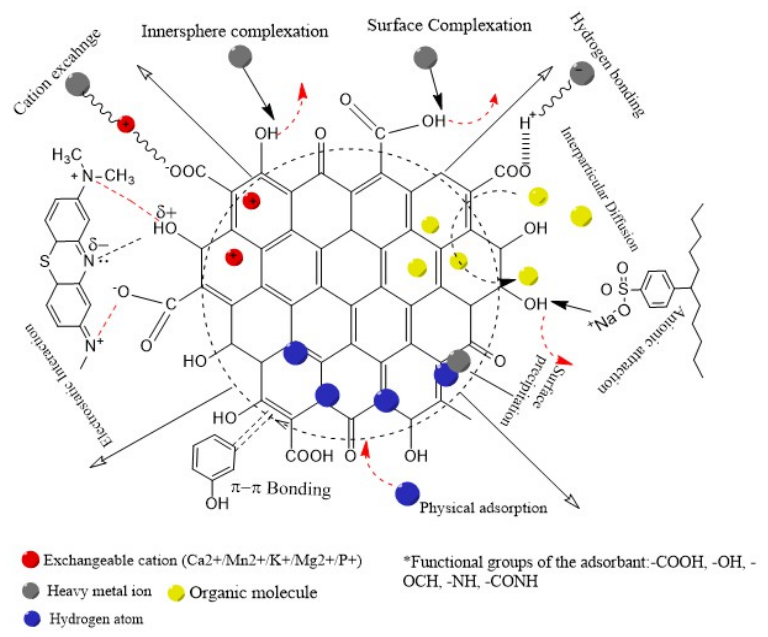
Figure 5. Adsorption mechanism of different types of pollutants on the AC surface.